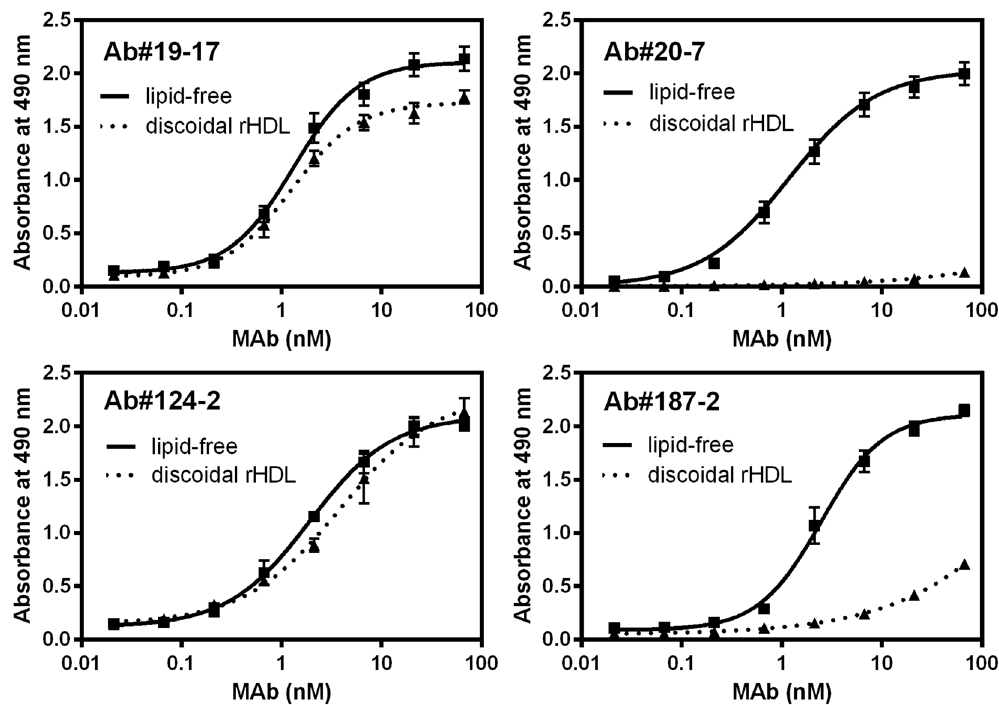
Figure 3. Reactivity of mAbs against apoA-I in the lipid-free state or on reconstituted discoidal HDL by ELISA. Biotinylated Cys-apoA-I in the lipid-free state or on discoidal HDL were added to 96-well microplates coated with streptavidin. After washing, Ab#19-17, Ab#20-7, Ab#124-2, or Ab#187-2 were added to the plates with increasing concentrations, and then detected with POD-conjugated anti-mouse IgG antibody.